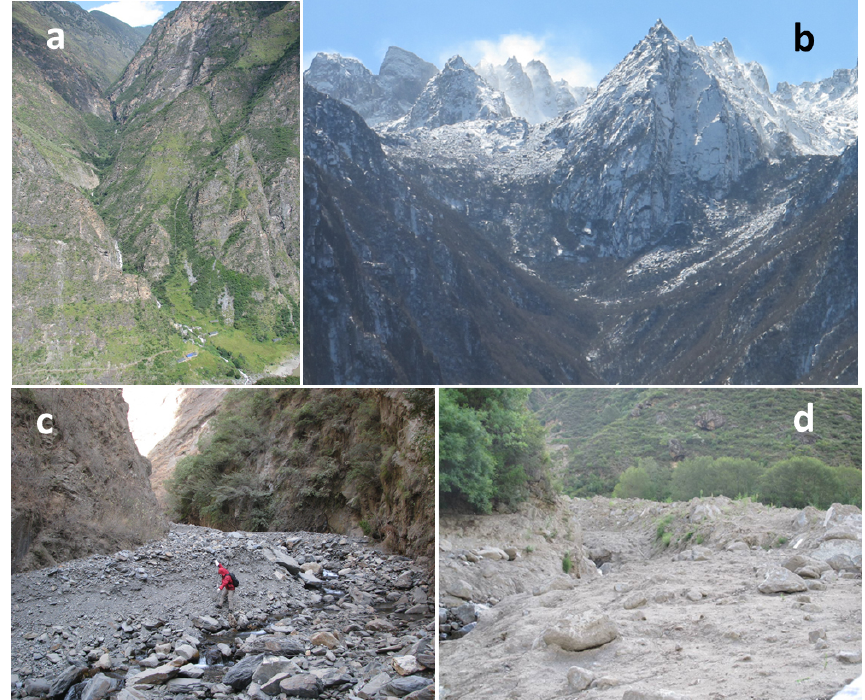
Figure 2. Typical debris flows in the study area.